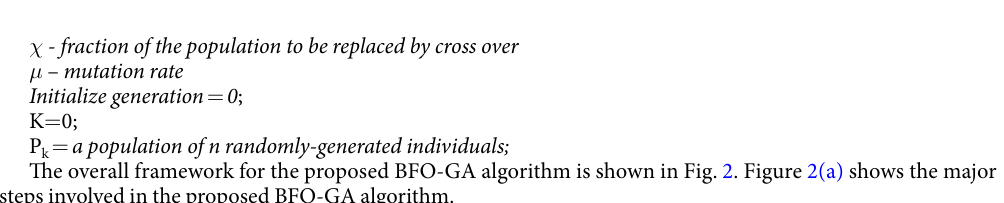
Figure 1. Pseudo code of the proposed BFO-GA